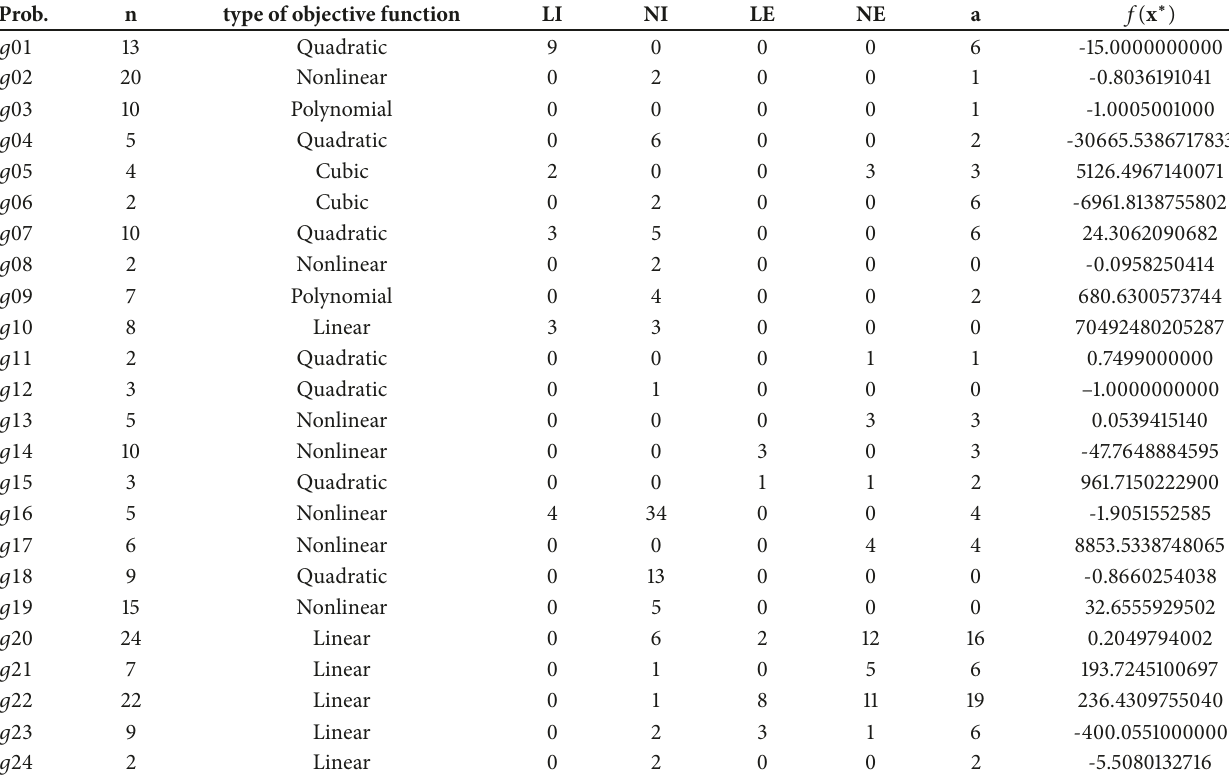
Table 1: 24 benchmark test